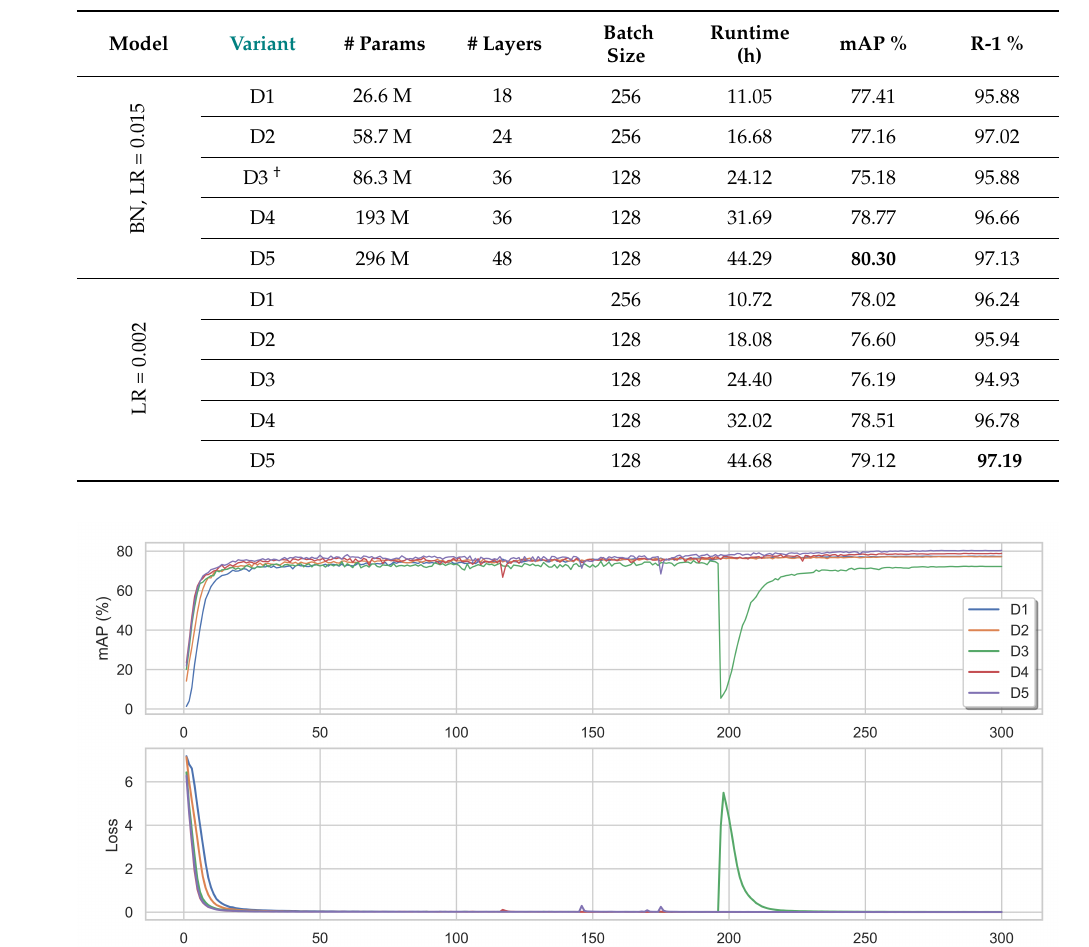
Table 13. Performance of the models using different VOLO variants. † refers to the models with unstable learning.